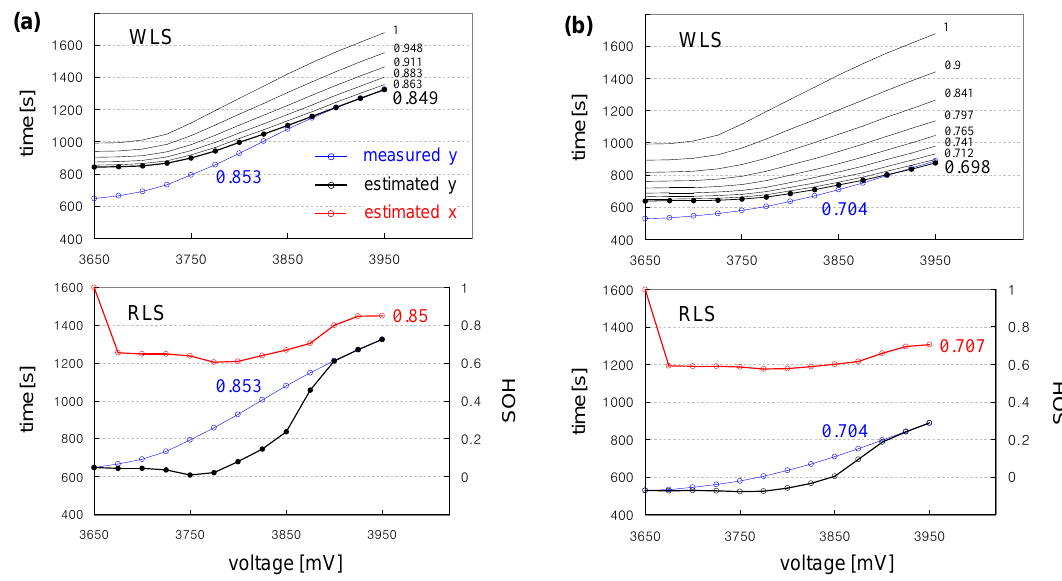
Figure 5. Comparison of WLS and RLS in terms of estimation error. The test data is obtained from the battery packs at ( a ) 85.3% SOH and ( b ) 70.4% SOH, which is consistent with that presented in Figure 12 in